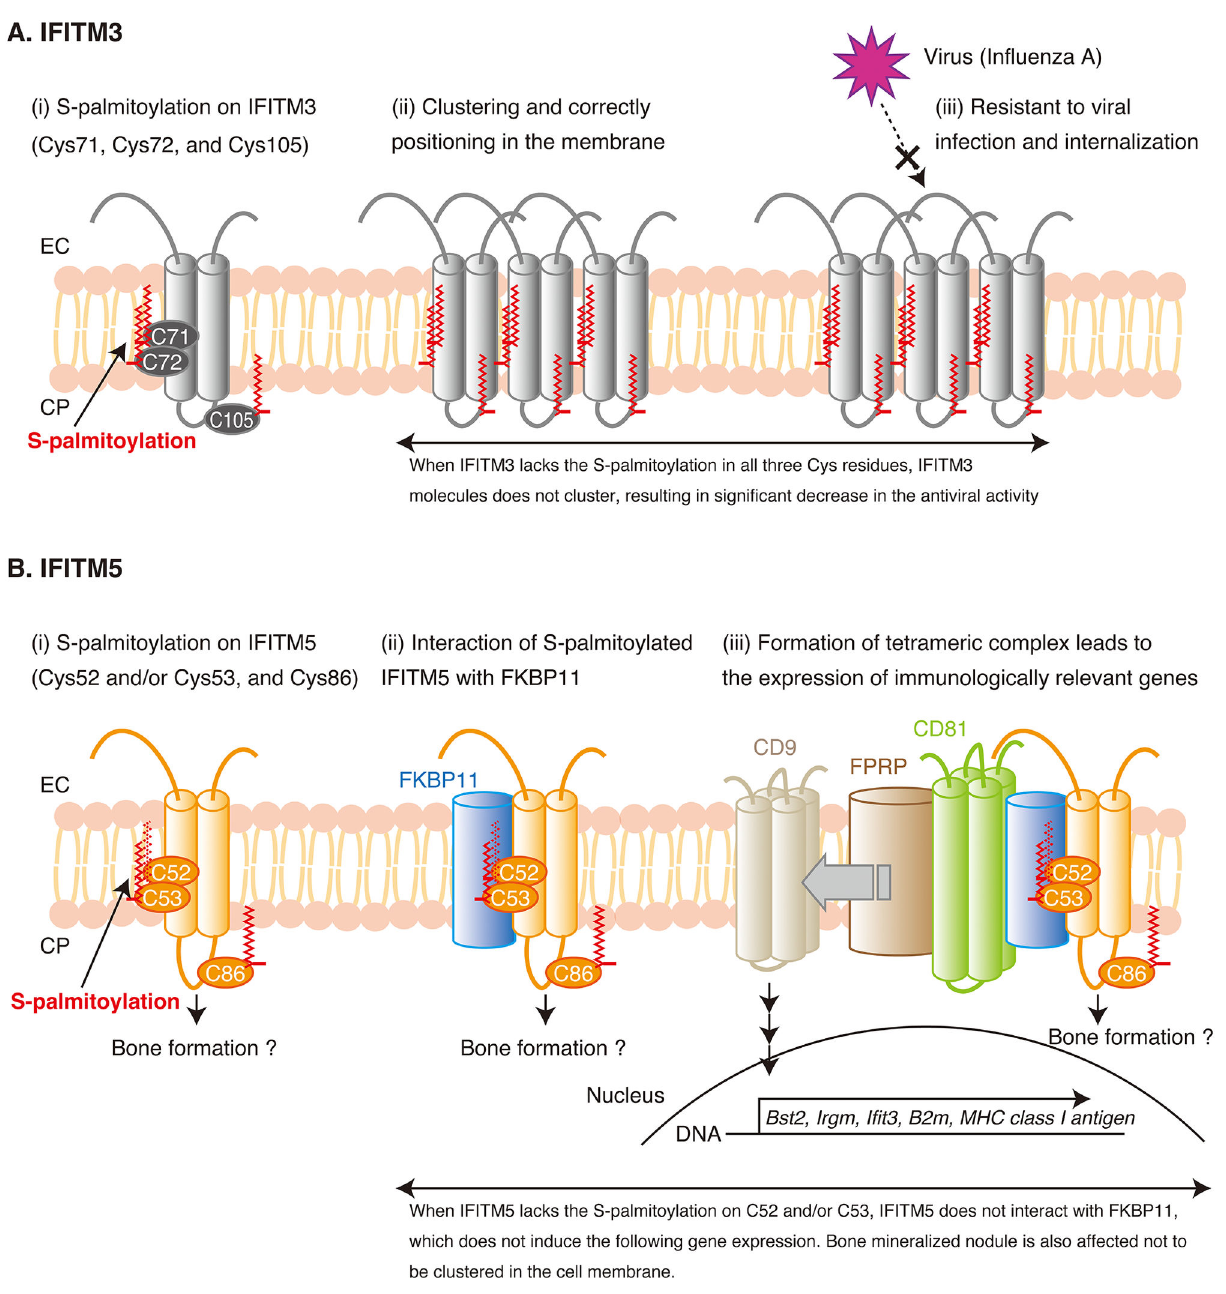
Figure 6. Possible functional mechanisms of IFITM3 and IFITM5 in cells. A) The functional mechanism of IFITM3 is summarized from previous studies. (i) IFITM3 is S-palmitoylated at Cys71, Cys72, and Cys105, (ii) which induces clustering and correct positioning in the membrane, (iii) resulting in the antiviral activity against influenza virus. B) The functional mechanism of IFITM5 is summarized by combining the results from the present and the previous studies. (i) Cys86, plus one or two other cysteine residues in IFITM5, i.e., Cys52 and/or Cys53, are S-palmitoylated (ii). The S-palmitoylation allows IFITM5 to interact with FKBP11 in the osteoblast cells (iii). The dissociation of CD9 from the FKBP11-CD81-FPRP/CD9 complex is induced by formation of the IFITM5-FKBP11-CD81-FPRP complex and leads to the immunologically relevant gene expression. IFITM5 also contributes to the bone formation, but it is unknown which states as described in (i)-(iii) are important for the bone formation at present.At present, no interactive protein has been identified in IFITM3 and IFITM2. On the other hand, IFITM5 interacts with the partner protein, FKBP11, and the S-palmitoylation clearly makes a significant contribution to the interaction. Therefore, IFITM5 forms a hetero-oligomer in the cell membrane for its physiological function. doi: 10.1371/journal.pone.0075831.g006 PLOS ONE |